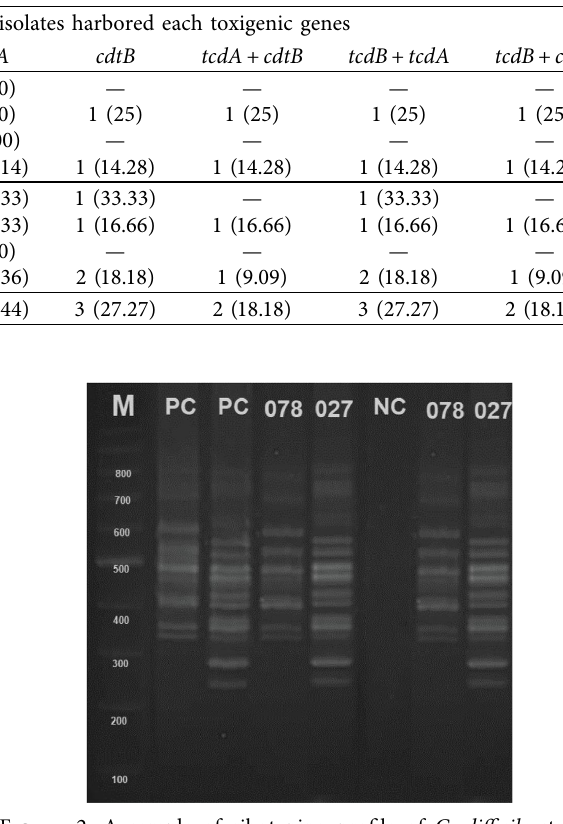
Table 4: Toxigenic genes distribution amongst the C. difcile strains.